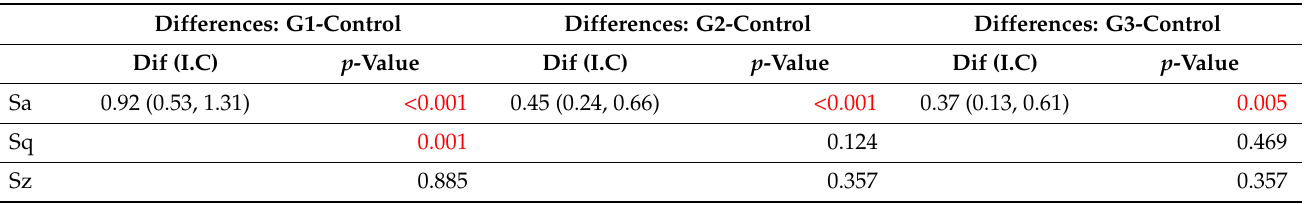
Table 3. Normality tests performed for each variable (Sa, Sq, Sz) and group at a 95% confidence interval. The red color stated for the statistically significant